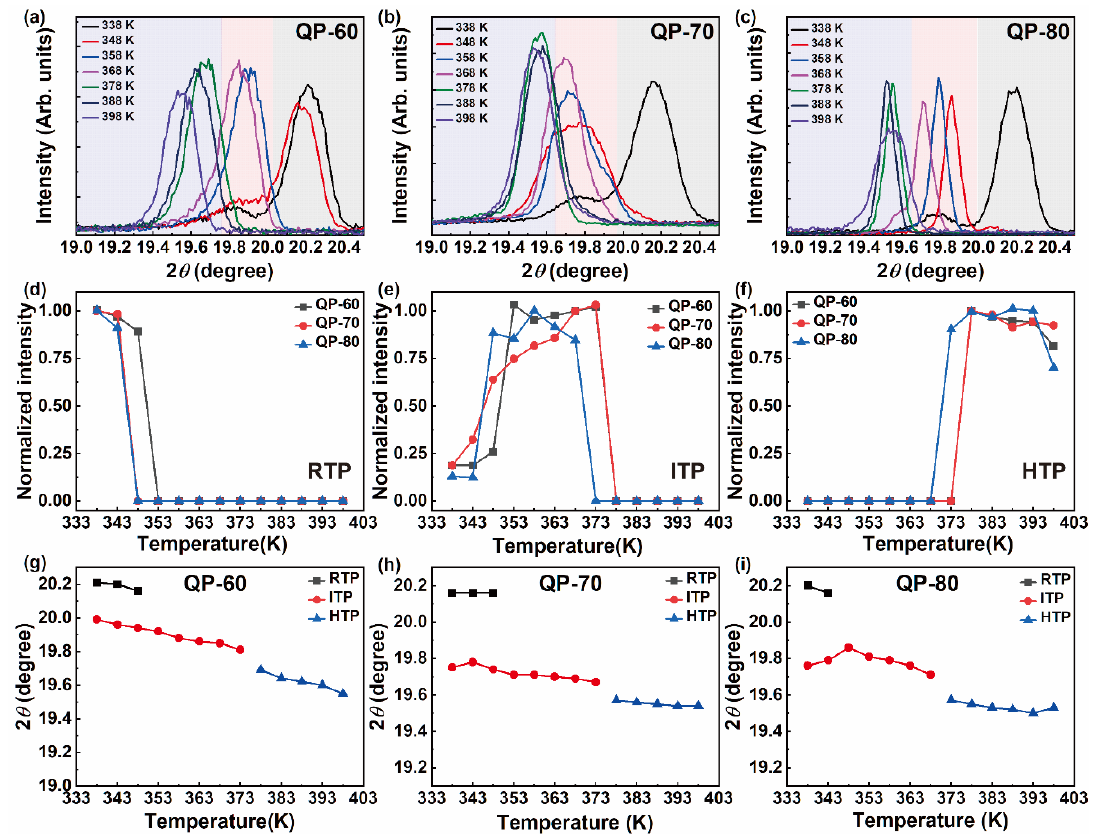
Figure 4. ( a – c ) The temperature-dependent XRD patterns of QP-60, QP-70, and QP-80 thin films. ( d – f ) The corresponding intensity variations of RTP, ITP, and HTP, respectively. ( g – i ) The temperature-dependent 2 θ variations in QP-60, QP-70, QP-80 thin films .